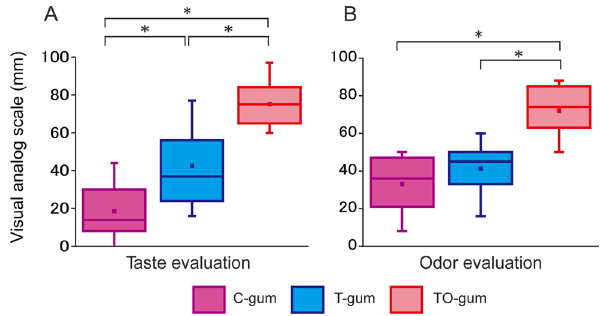
Figure 1. Summaries of Visual Analog Scales (VAS) of taste (A) and odor (B) of tested gums (N=25). Each scale ranged from 0 (worst) to 100 (best). The boxes are constructed with the top line bounding the first-quartile and the bottom line bounding the third quartile. The horizontal line and the dot in the box indicate the median and mean values, respectively. The short horizontal lines show the largest and smallest values. **P , 0.01, ***P , 0.001. C-gum (purple): the gum with no taste and no odor (control), T-gum (blue): the gum with the sweet taste only, and TO-gum (red): the gum with sweet taste and lemon odor.